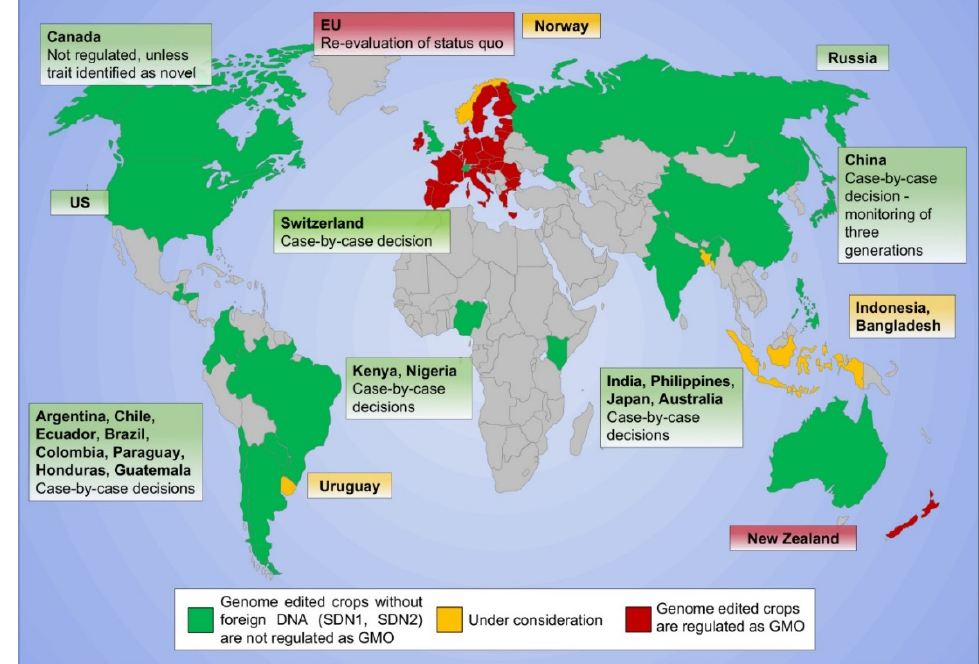
Figure 6. Global state of regulation of genome editing (Adapted with permission from John Wiley Ref. [205]).